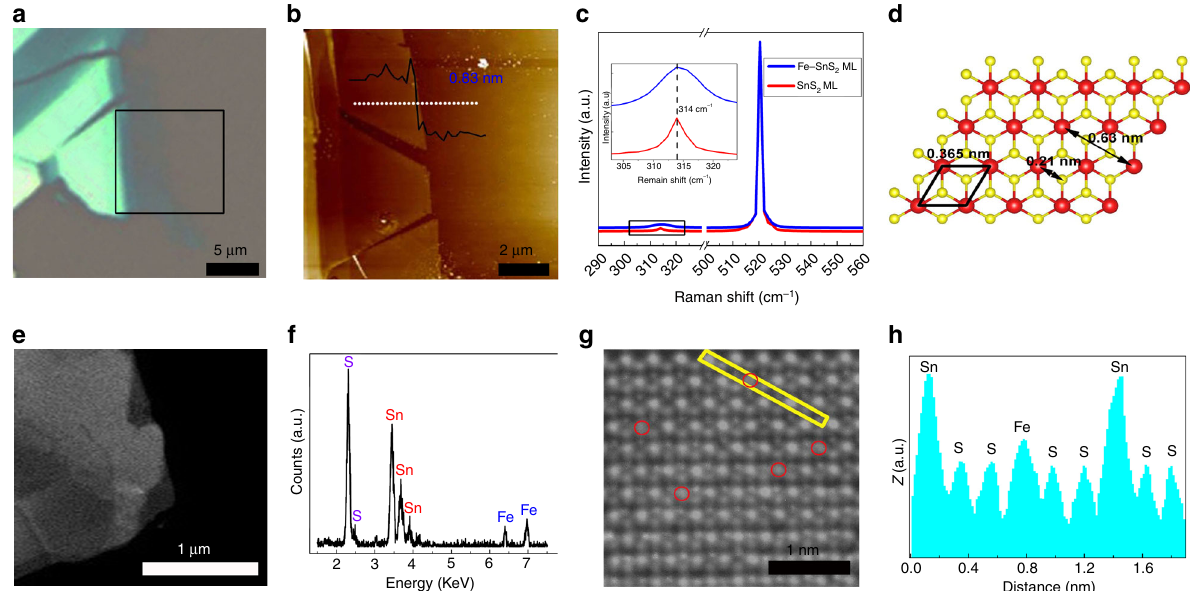
Fig. 1 Characterization of the Fe 0.021 Sn 0.979 S 2 fl akes. a Optical image of the Fe 0.021 Sn 0.979 S 2 fl ake. b AFM and c Raman spectra of the Fe 0.021 Sn 0.979 S 2 and SnS 2 monolayers. The height of the fl ake in b was obtained along the white dotted line. The inset in c shows the expanded view of the Raman spectra around the A 1 g mode of the Fe 0.021 Sn 0.979 S 2 and SnS 2 monolayers. d SnS 2 atomic structure. e Low-resolution HAADF-STEM image of the Fe 0.021 Sn 0.979 S 2 fl ake. f EDS of the Fe the areas marked with yellow rectangles in